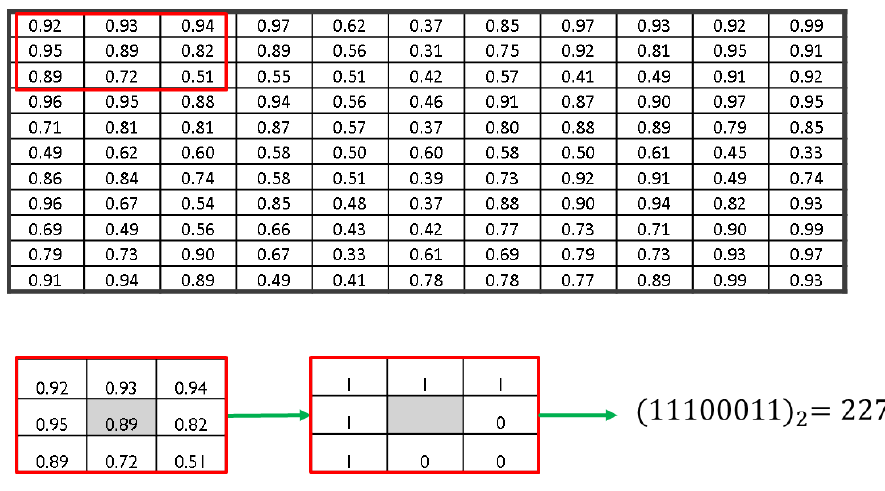
Figure 4. Local Binary Pattern (LBP) image encoding of a 2-D